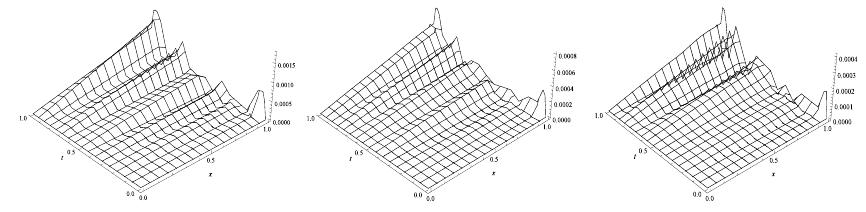
Figure 3. Max absolute error with ε = 10 − 8 and n = 10 (Left: N = 200; Middle: N = 400; Right: N = 800) for Example 3.